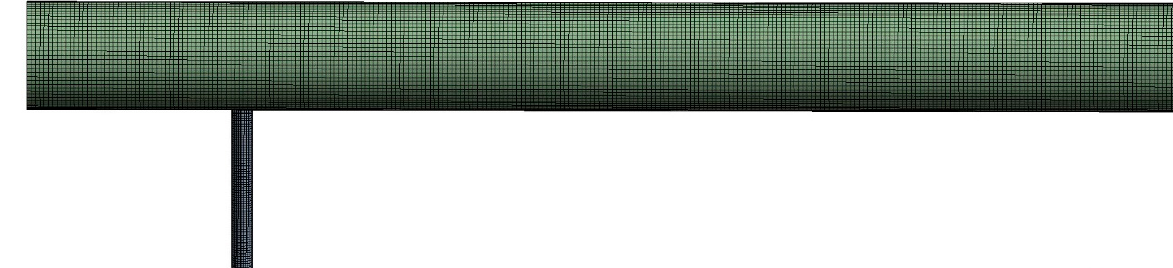
Figure 2. Mesh generation.